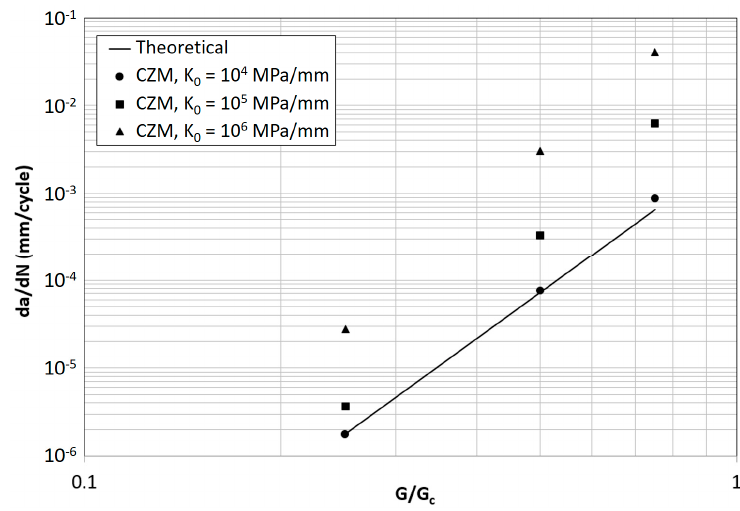
Materials 2019 , 12 , 181 Figure 6. Theoretical and predicted FCG rate for different values of K 0 and G/G c ( σ 0 = 30 MPa).